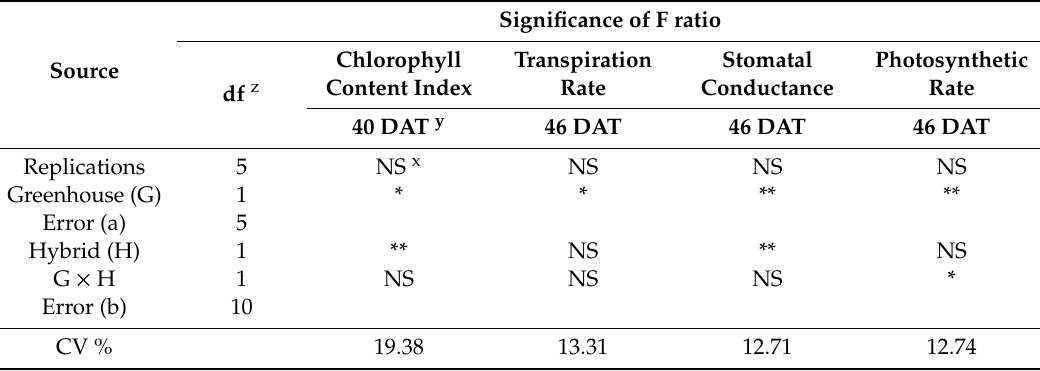
10 19.38 13.31 12.71